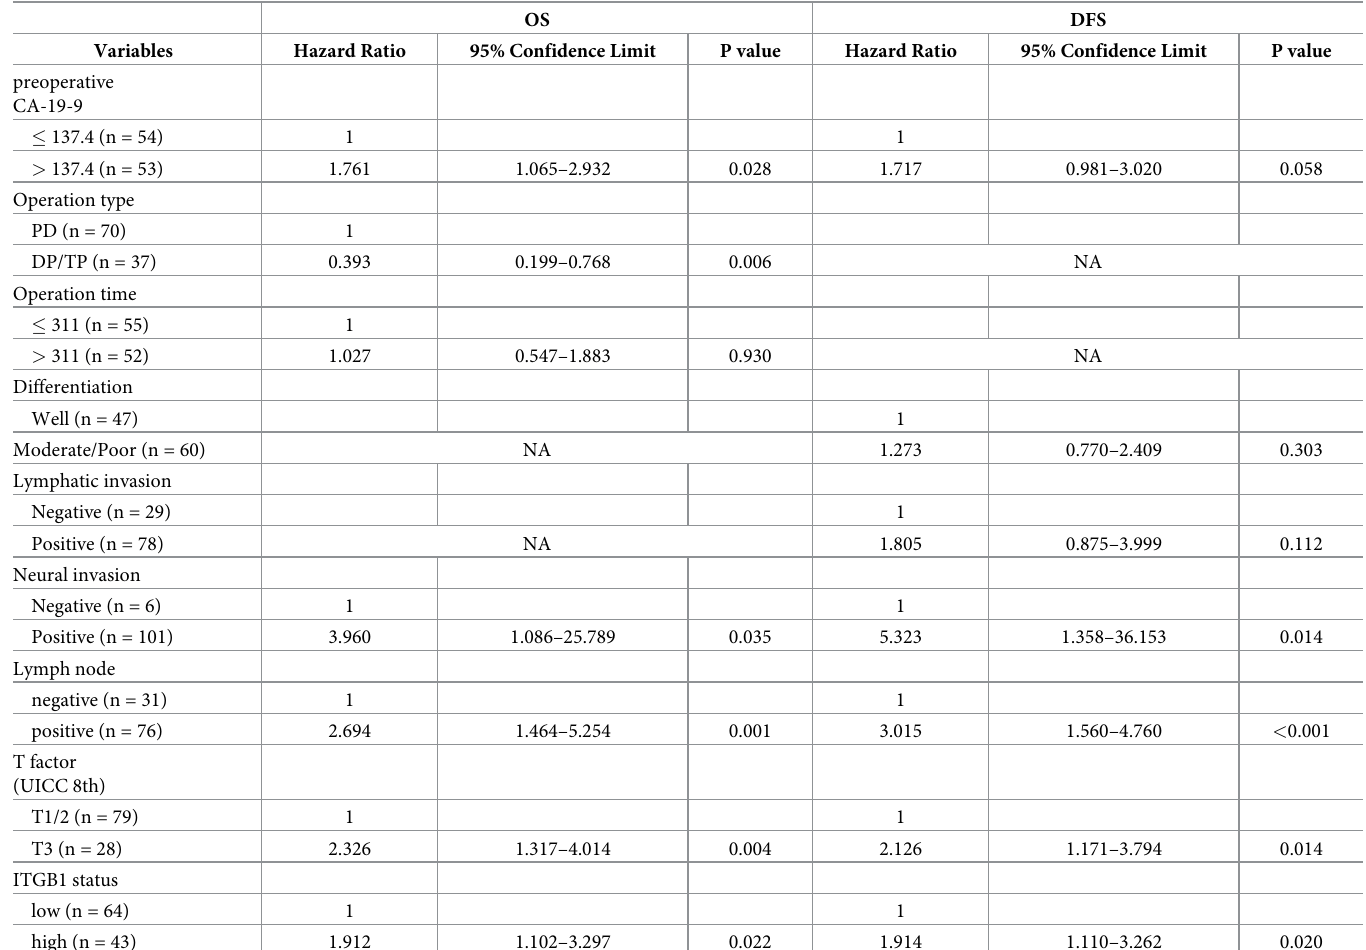
Table 3. Multivariate analysis of prognostic factors for OS and